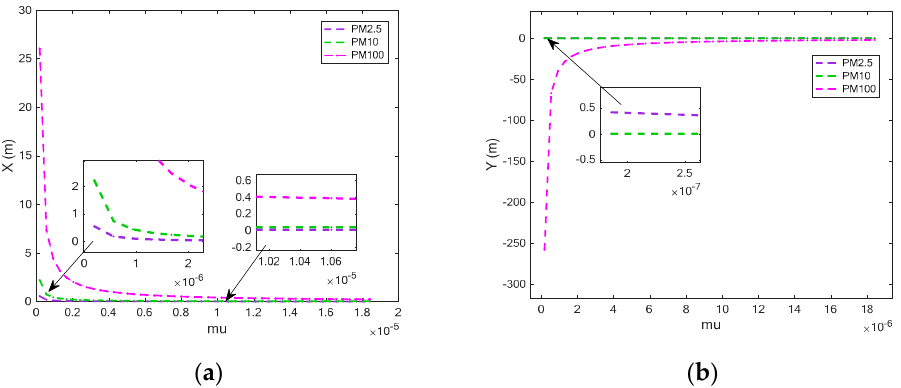
Figure 10. Variation of the drag coefficient of particle separation displacement: ( a ) Displacement in the X direction; ( b ) displacement in the Y direction.